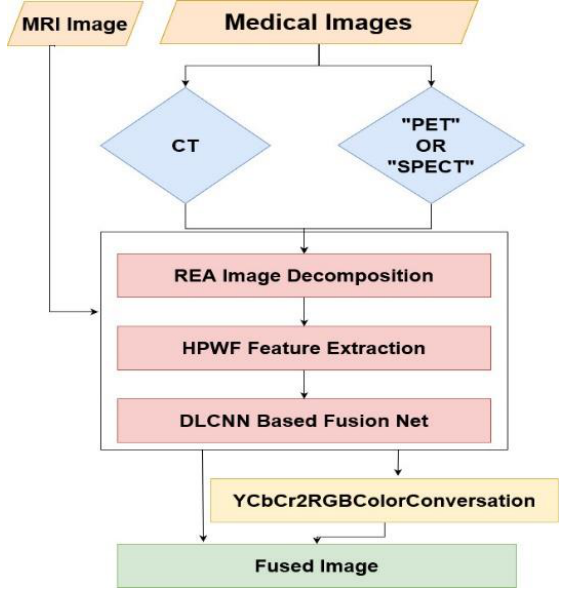
Figure 2. Hybrid DLCNN for MRI-CT/PET/SPECT image fusion. By subtracting the blurred input photos from the represented input images using HPWF, crisp images are produced. The fused output is then produced by combining the results from the HPWF and REA. The operational technique of the recommended method is shown in Table 3. Table 3. Proposed Fusion algorithm.